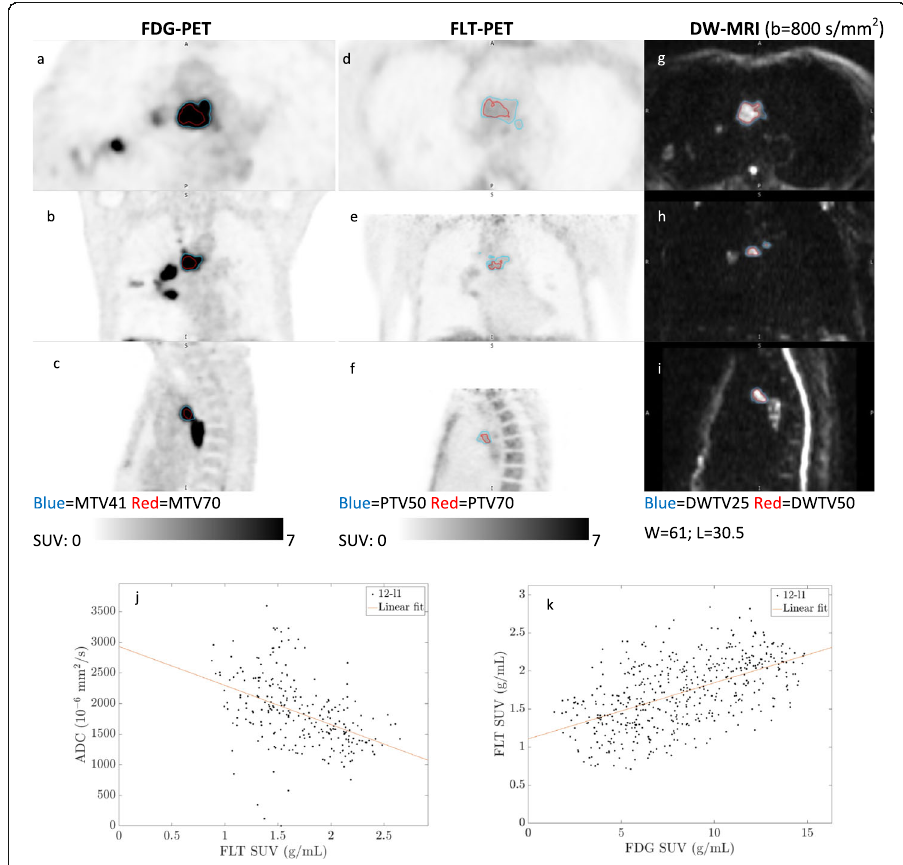
Fig. 5 N-site (12-N1): FDG-PET (axial ( a ), coronal ( b ), sagittal ( c )), FLT-PET (axial ( d ), coronal ( e ), sagittal ( f )), and DW-MRI (transversal ( g ), coronal ( h ), sagittal ( i )), and voxel-by-voxel scatterplot of FDG-SUV vs. FLT-SUV ( j ), and FLT-SUV vs. ADC ( k ). This N-site were clearly detectable on FDG-PET (SUV peak 11.6), FLT-uptake was the highest of all N-sites (SUV peak 2.4), and detectable on DW-MRI (ADC median 1.56 × 10 − 3 mm 2 /s). The most aggressive regions (MTV70, PTV70, and DWTV50) were located centrally within the tumor on all imaging modalities, and voxel-by-voxel correlations were moderate for FDG-SUV vs. FLT-SUV ( r = 0.55) ( j ) and for FLT- SUV vs. ADC ( r = − 0.44) ( k ). This N-site progressed during